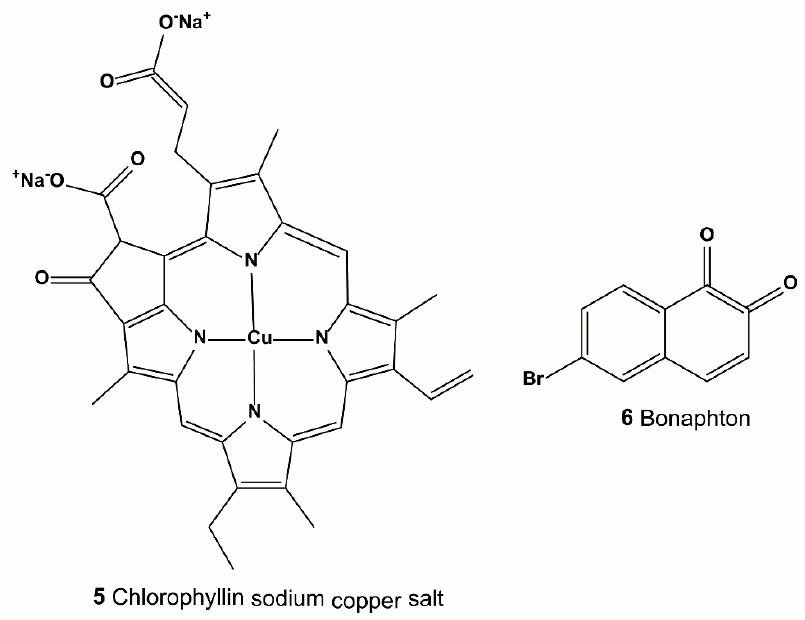
Figure 5. Structures of compounds 5–6 .